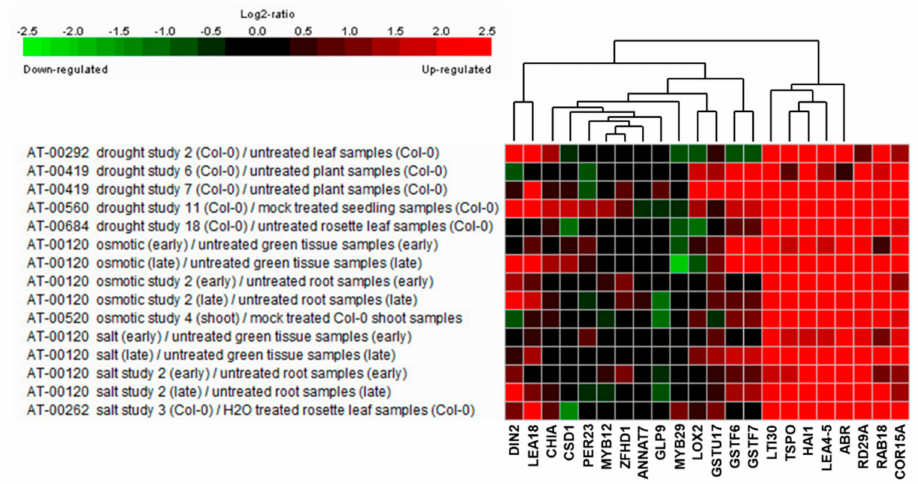
Figure 6. Expressionanalysisof19stress-responsivegenesunderdrought,osmotic,andsaltstressconditions using Genevestigator. RD29A , RAB18 , and COR15A were used as marker genes for stress